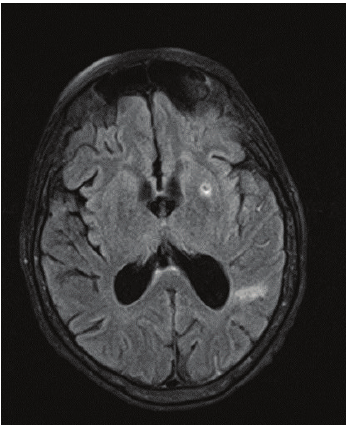
Figure 1: MRI of the brain demonstrating punctate areas of intraparenchymal